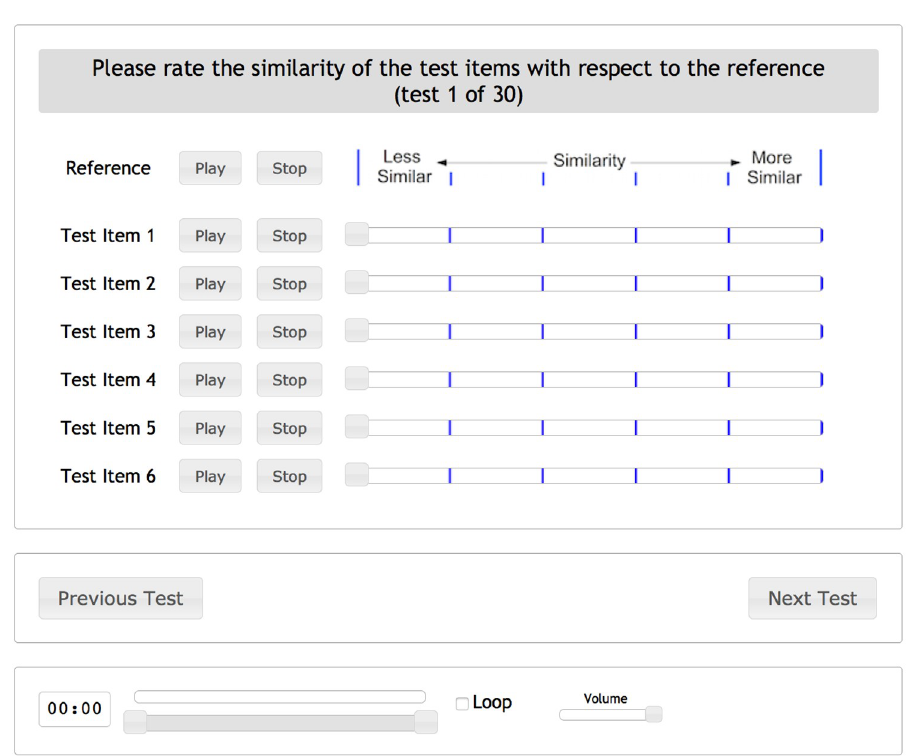
Fig 1. Graphical interface of a single test page used for the online listening test. Listeners were asked to rate the similarity between the imitation (reference) and 6 test items (same–category drum sounds), on a continuous scale from ‘less similar’ to ‘more